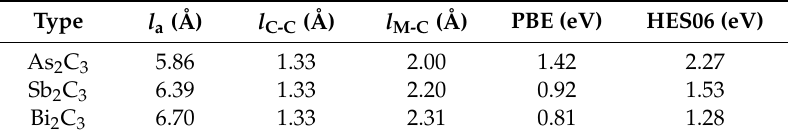
Figure 1. Top ( a ) and side ( b ) view for monolayer M 2 C 3 . The band structures and corresponding projected density of states (PDOS) for ( c ) As 2 C 3 , ( d ) Sb 2 C 3 , and ( e ) Bi 2 C 3 . Table 1. The lattice constants ( l a ), bond lengths of C-C ( l C-C ), bond lengths of M-C ( l M-C ), and band gaps based on Perdew–Burke–Ernzerhof (PBE) and